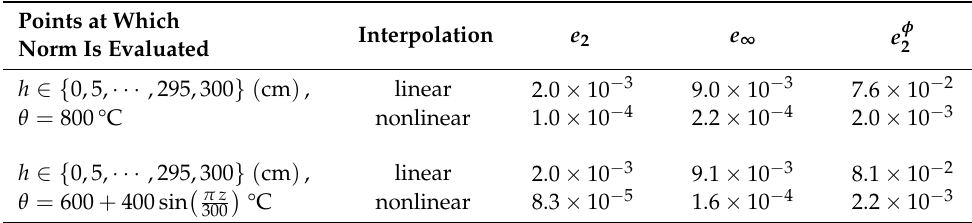
Table 6. Error in k eff and the scalar flux predicted by reduced-order model (LPOD) for unseen ROM parameters as stated. Values for both the linear and nonlinear interpolation are